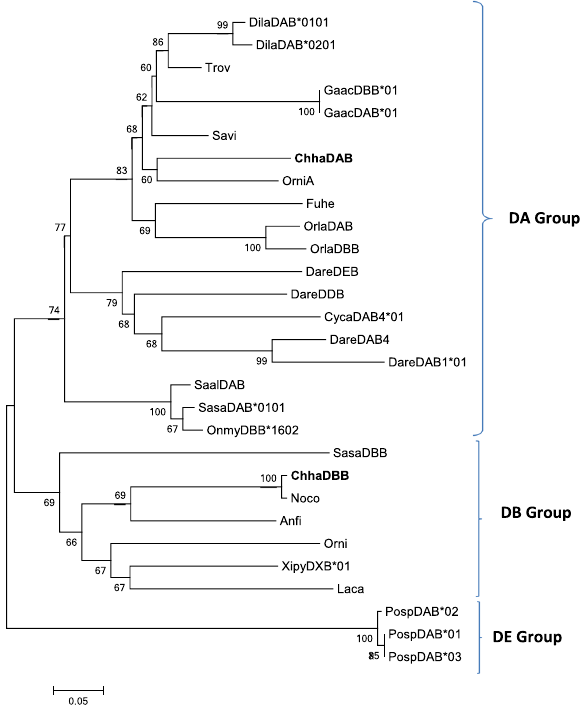
Figure 2. Phylogenetic tree analysis of icefish MHC II β sequences with selected fish MHC sequences. The phylogenetic tree was constructed using amino acid multiple alignments and the Neighbour-Joining method within the MEGA7 program. The percentage of replicate trees in which the associated taxa clustered together in the bootstrap test (10,000 replicates) was shown next to the branches. 0.1 indicates the genetic distance. Accession numbers are the same as reported in Fig. 1, with the exception of: Oryzias latipes